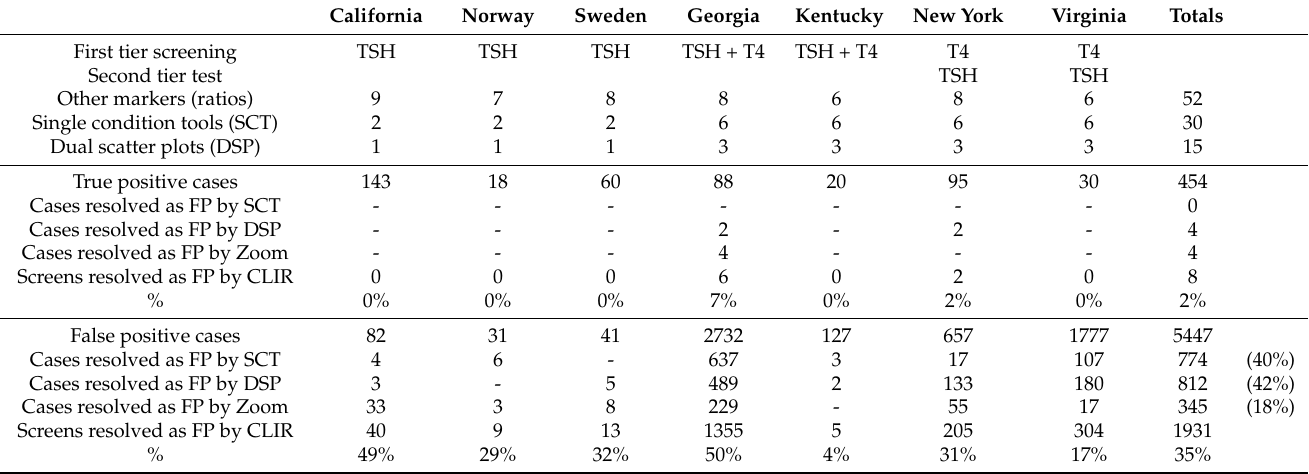
Table 5. Resolution of cases by location in the Verification